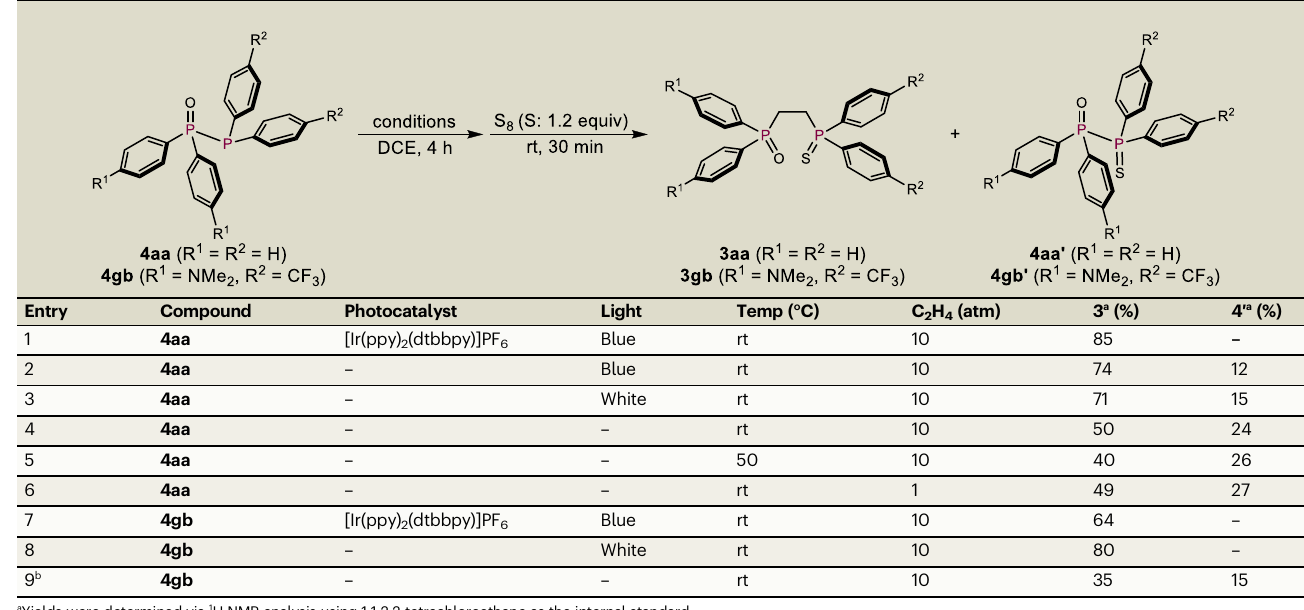
Table 2 | Ethylene Insertion into Diphosphine 4aa and